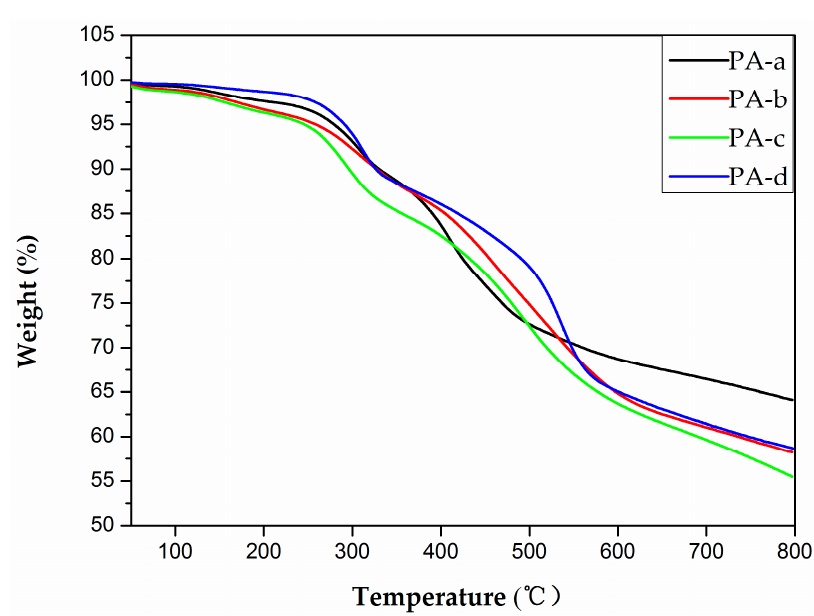
Figure A10. TGA of PAs. Figure A10. TGA of